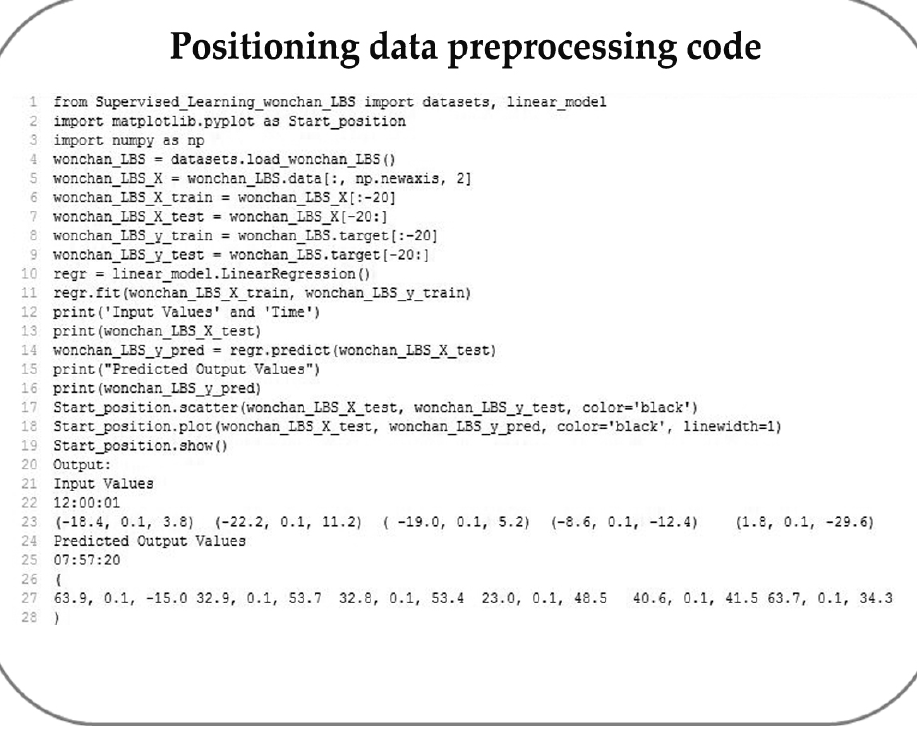
Figure 8. Positioning data preprocessing code.